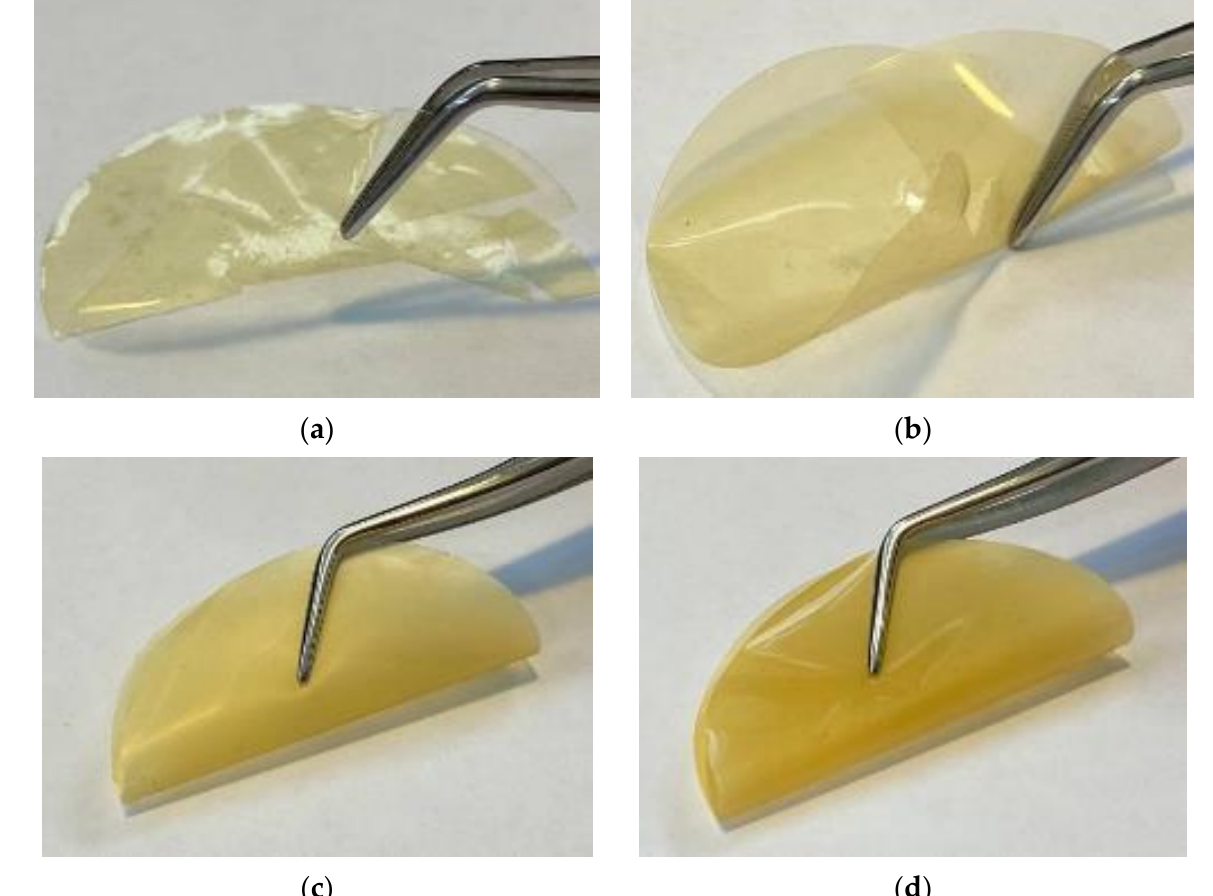
Figure 4. PTMSP ( a ), PTMSP/HCPS 1.0 wt % ( b ), PTMSP/HCPS 2.0 wt % ( c ) and PTMSP/HCPS 5 wt % ( d ) films after 400 h of annealing at 100 °C.